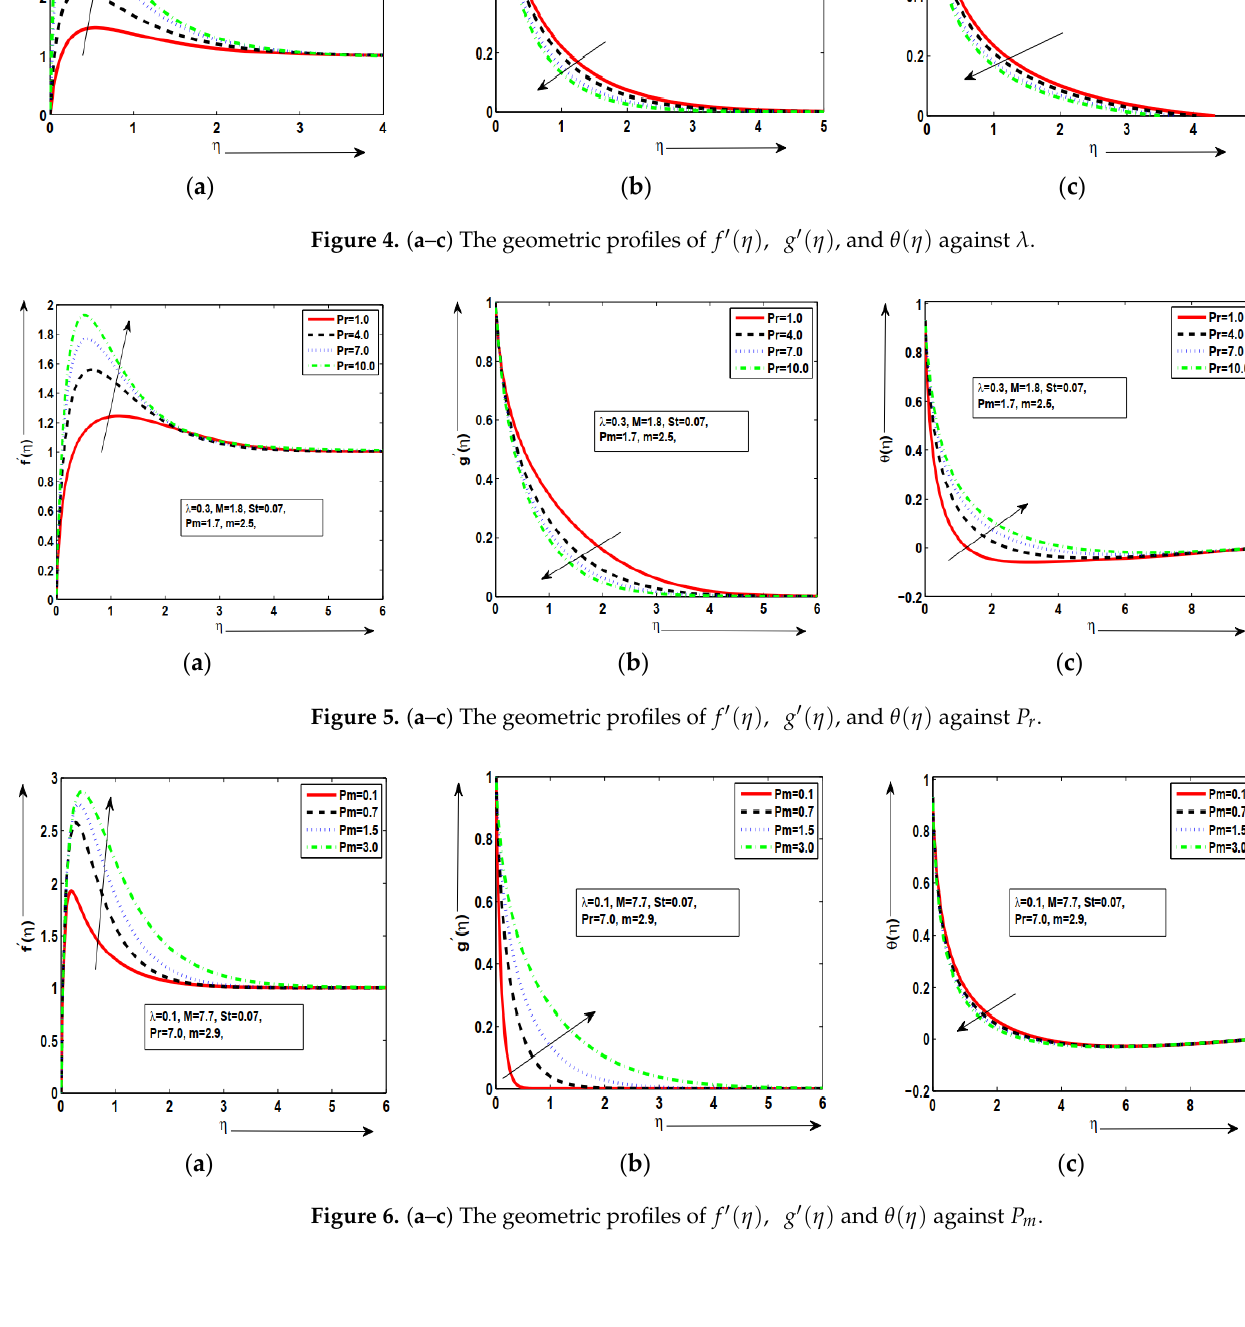
Figure 6. ( a – c ) The geometric profiles of f (cid:48) ( η ) , g (cid:48) ( η ) and θ ( η ) against P m